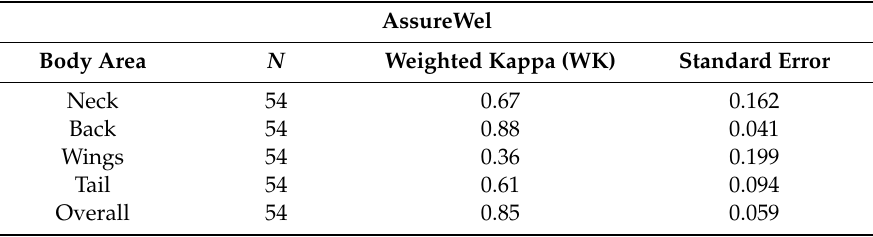
Table 3. Intra-observer reliability of feather damage (FD) scoring in laying hens based on the AssureWel scoring system (0–2 scale) following initial testing. Di ff erent body areas were assessed, and one overall score was given based on the overall impression of the hen. Reliability was assessed as weighted kappa